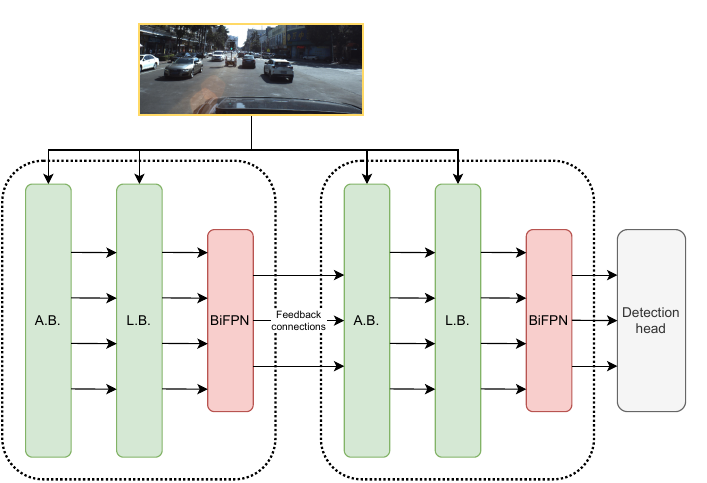
Figure 6. RPF unrolled to a two-step sequential network; A.B. and L.B. refer to assistant backbone and lead backbone,